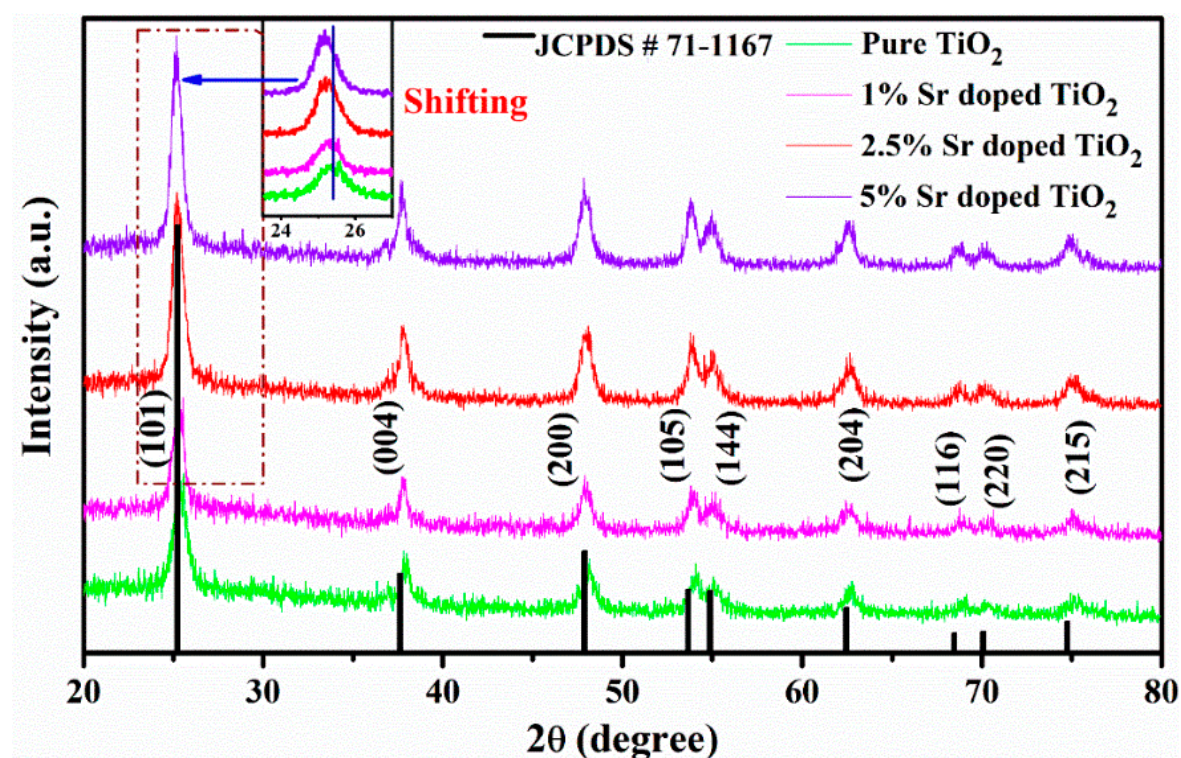
Figure 2. Overlaid XRD patterns of pristine TiO 2, 1%, 2.5% and 5% Sr-doped TiO 2 NPs.